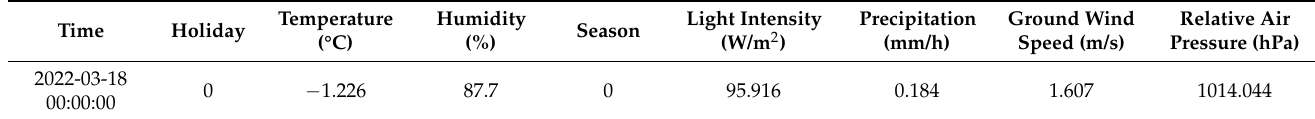
Table 4. The data of 8 characteristic factors for one point on 18 March 2022, where 0 represents working days and 1 represents holidays for the factor of holiday; 0, 1, 2 and 3 represent spring, summer, autumn and winter for the factor of season,